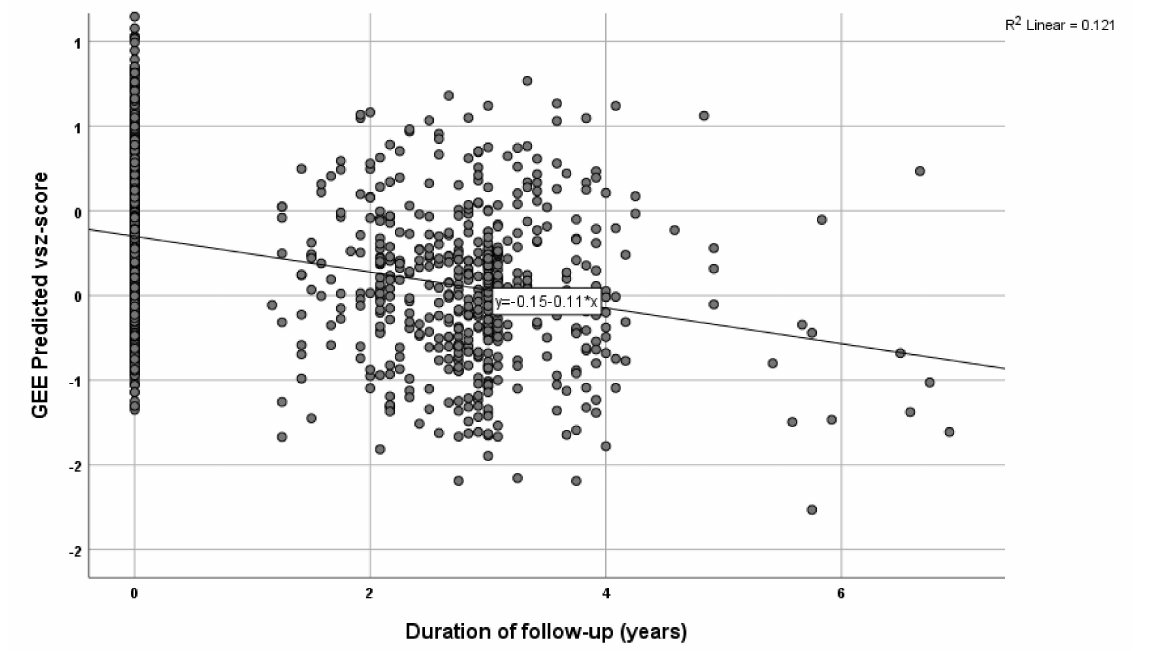
Figure 2. Graphic illustration of the cognitive decline in visuo-spatial ability over time (covariates are